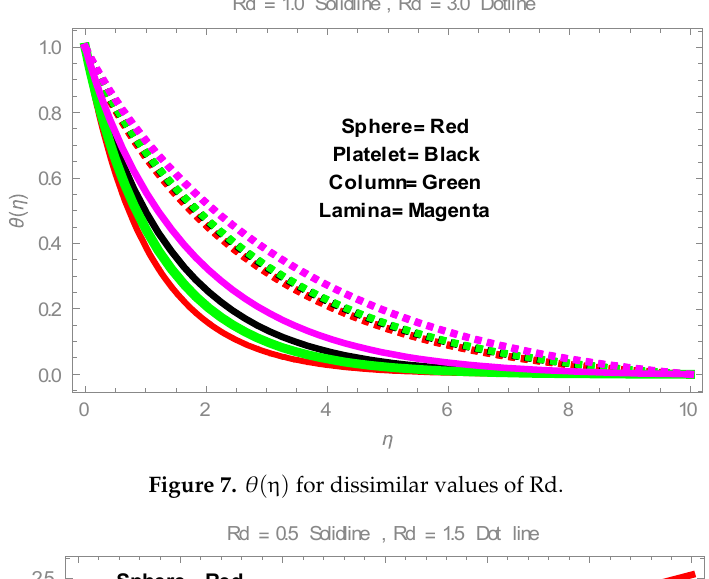
Figure 6. (cid:1858) (cid:4593) (η) and (cid:2016)(η) for dissimilar values of (cid:1827) .